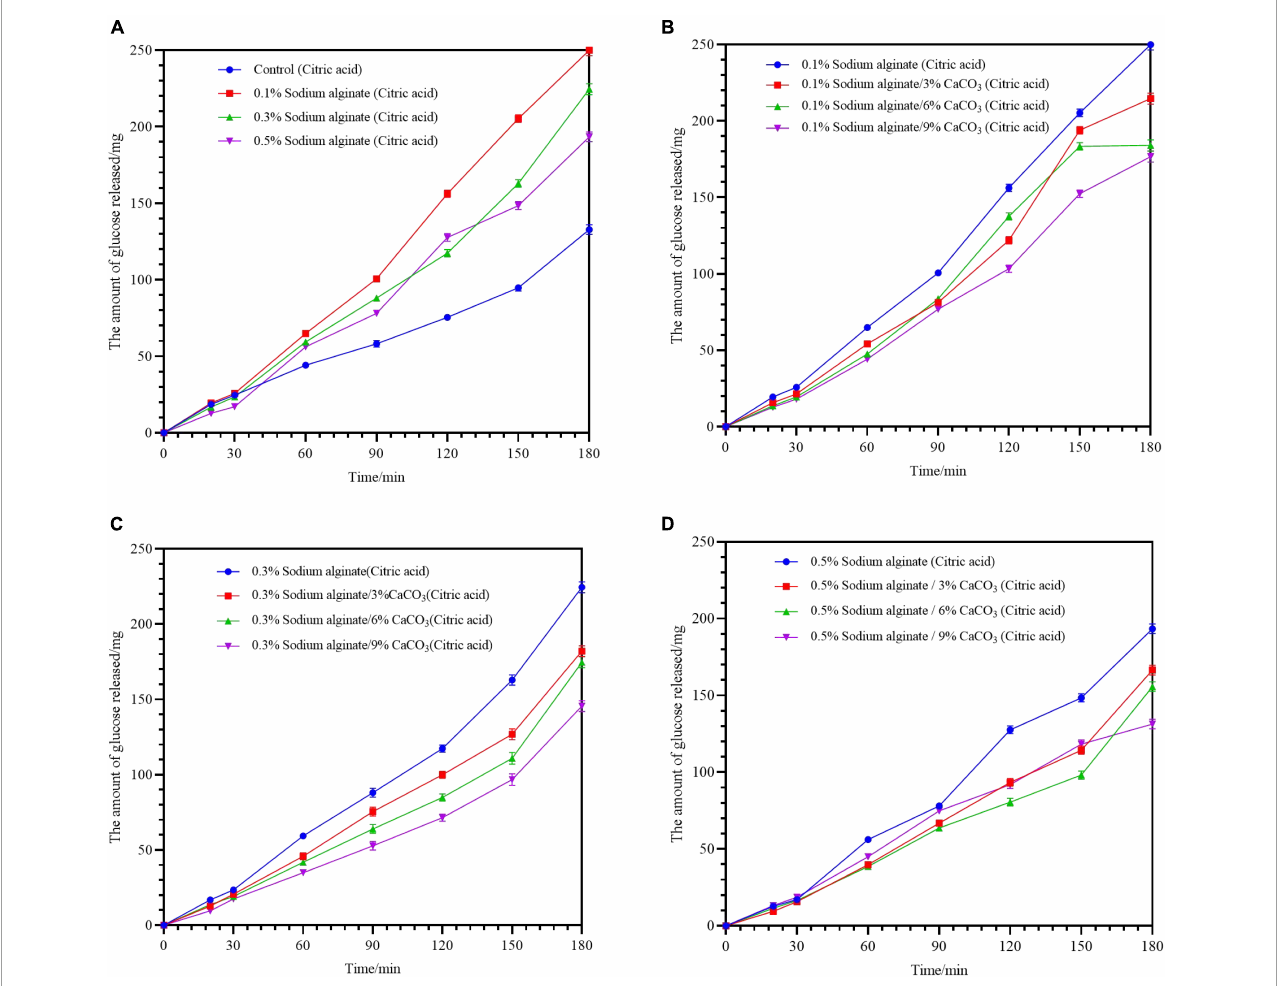
FIGURE4 (A–D) Show the effects of varying Ca 2 + concentrations on the digestibility of buckwheat noodles prepared by the endogenous method. The solution environment for cooking noodles in panels (A–D) is 0.2 g/L citric acid solution (pH =